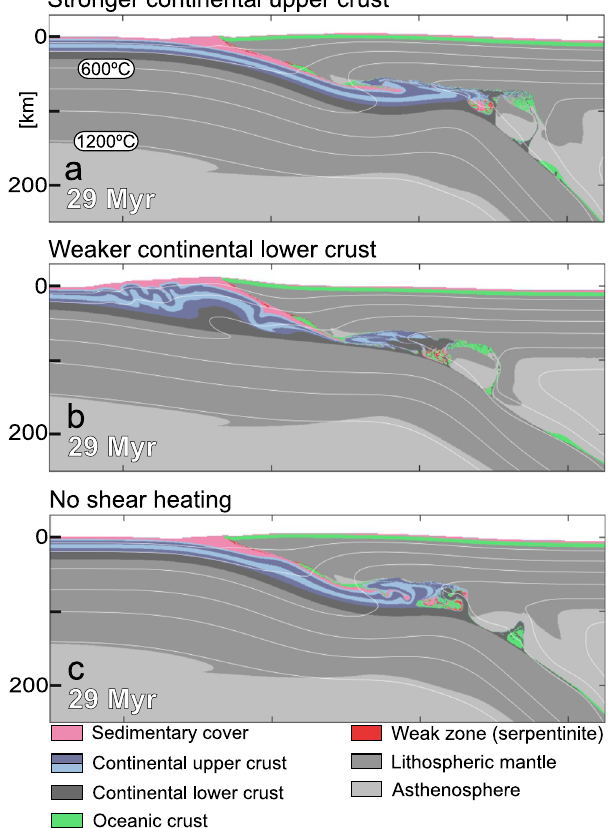
Fig. 4 Effects of changing key parameters compared to the reference model setup. a Model compositions at 29 Myr with stronger upper crust rheology (Maryland diabase instead of Westerly granite) 24,26 . For the initial strength pro fi le of the continental domain see Fig. 2a. b Model compositions at 29 Myr with weaker lower crust rheology (Maryland diabase instead of ma fi c granulite) 25,26 . For the initial strength pro fi le of the continental domain see Fig. 2a. c Model compositional domains at 29 Myr with shear heating switched off.